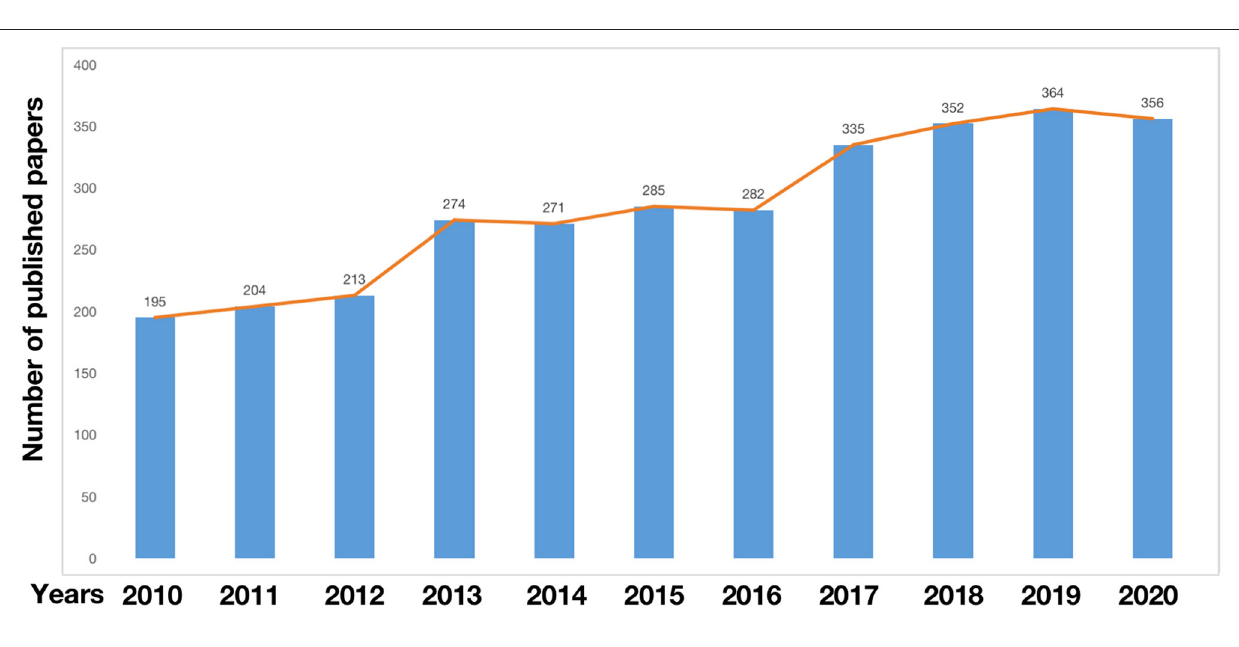
FIGURE 2 | Annual trend chart of